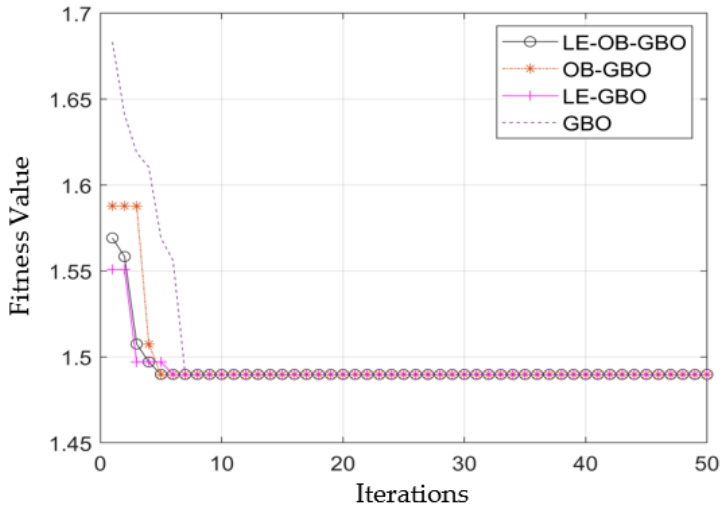
Figure 5. Convergence curve for the charging station placement problem—case 1.